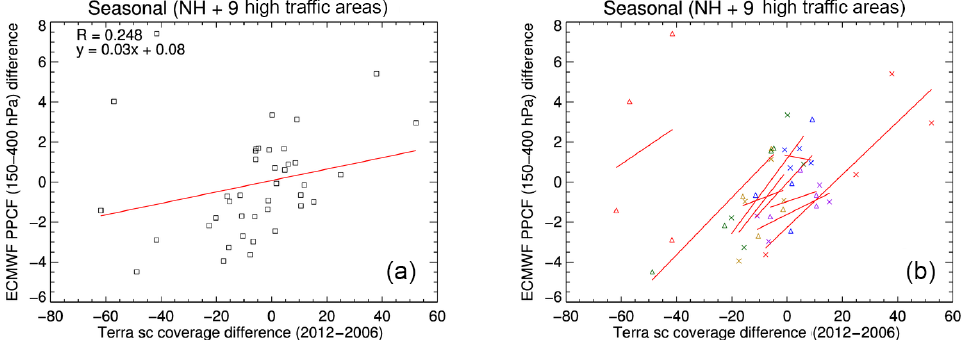
Figure 8. Scatter plots of relative year-to-year difference in Terra MODIS-derived CC (in %) versus absolute (2012–2006) difference in PPCF (in %) computed from ERA-Interim reanalyses of the upper troposphere (150–400hPa). (a) Linear regression based on data from all 10 regions. (b) Linear regressions of each air traffic region: NH – blue crosses, N Atlantic – red crosses, CONUS – green crosses, Europe – dark yellow crosses, W Asia – purple crosses, E Asia – blue triangles, Europe–LA – red triangles, HI–CONUS – green triangles, NE Pacific – dark yellow triangles, NW Pacific – purple